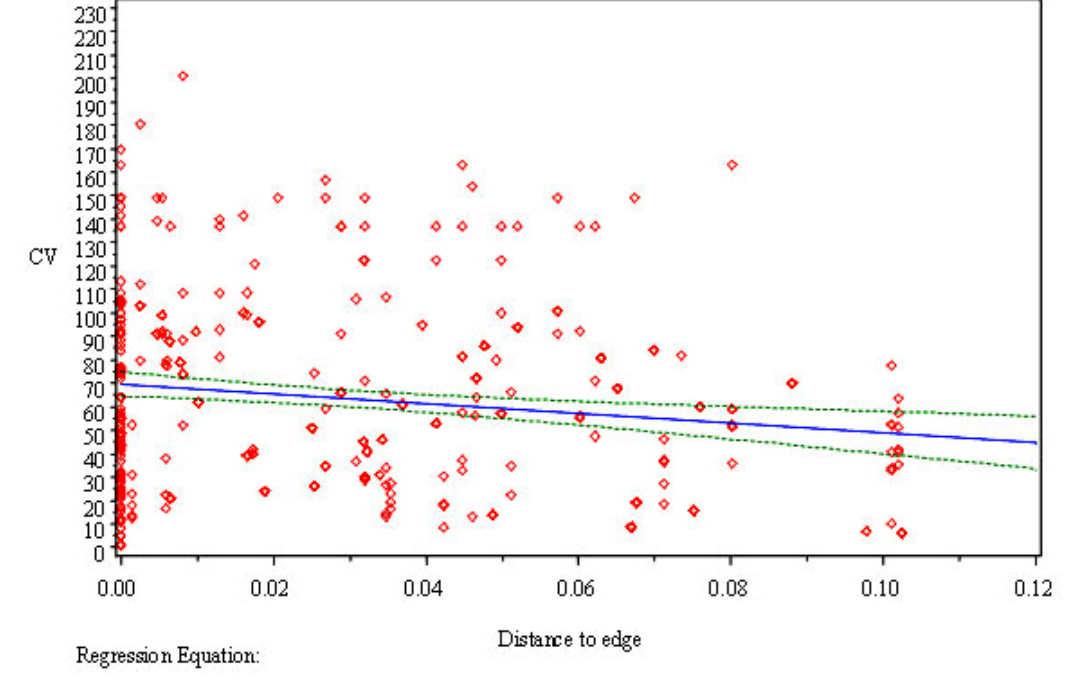
Fig. 5. Plot of coefficient of variation (CV) in relation to distance-to-edge (edge) of truncated data for temporal analysis of bird species of the Florida Everglades sub-ecoregion. Each point (diamond) represents one species at one BBS route and their respective CV and edge. The regression line (solid line) is accompanied by its 95% confidence limits (dashed